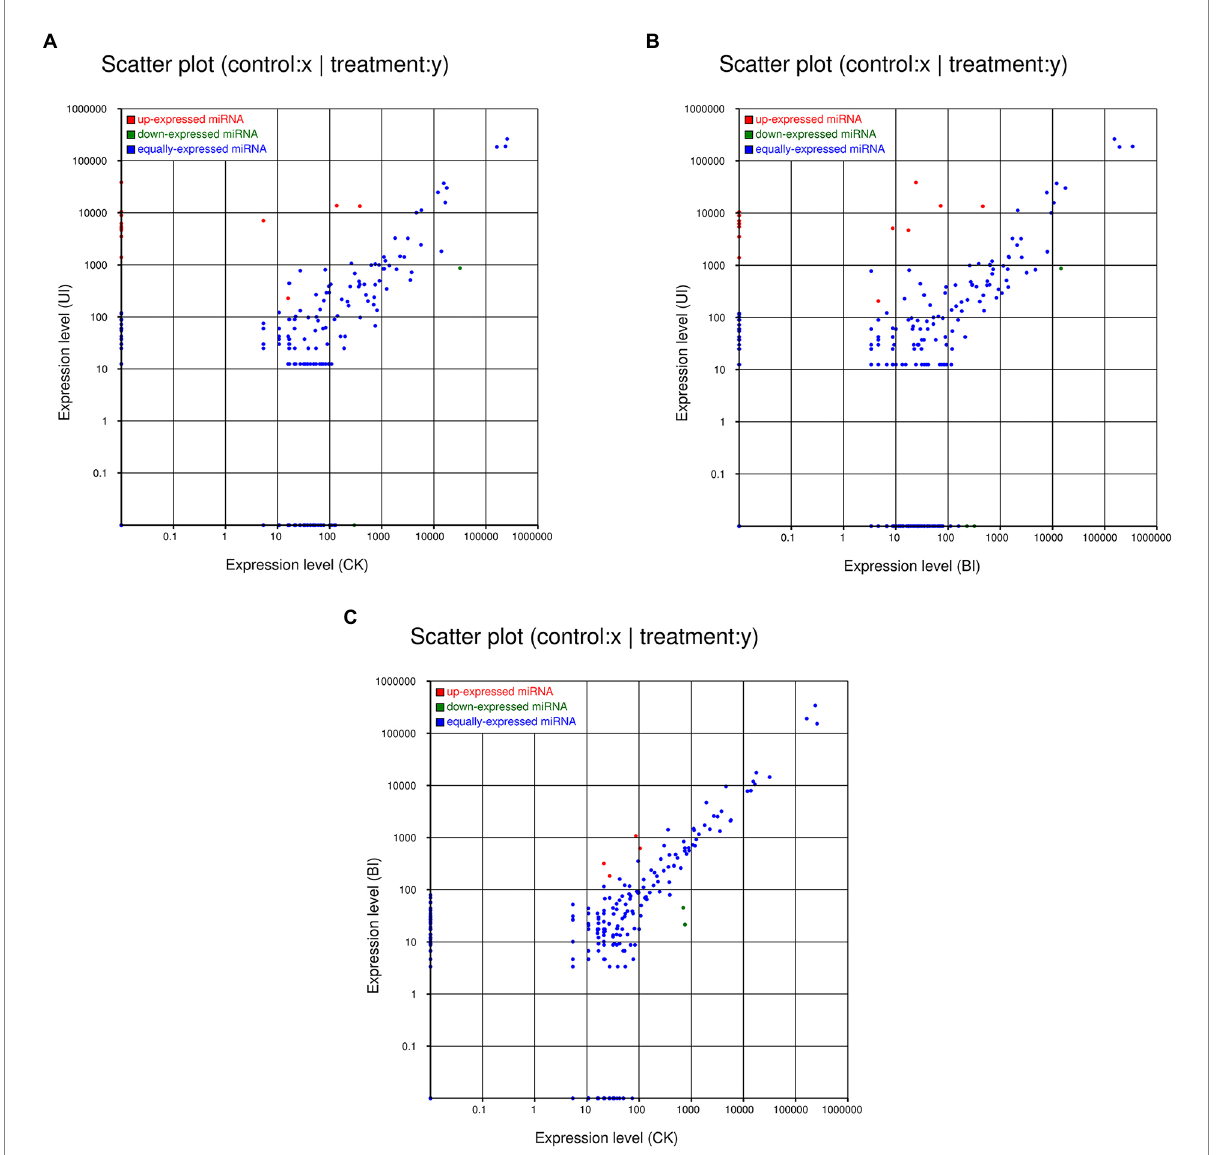
FIGURE 5 Comparisons of the different expression patterns of novel miRNAs between each pair of groups. Each point in the scatter plots represents one miRNA. The x -axis and y -axis individually show the expression levels between the two libraries. The red dots indicate a more abundant expression in the y -axis library (fold change > 1, p < 0.05); the blue dots indicate equal expression between the two libraries ( − 1 < fold change < 1, p > 0.05), and green dots indicate less enrichment in the y -axis library (fold change < − 1, p < 0.05). (A) Expression in the CK (control check, without inoculation) vs. expression in the UI (symbiotic phase, 5 weeks after inoculation), (B) expression in the BI (presymbiotic phase, 3 weeks after inoculation) vs. expression in the UI (symbiotic phase, 5 weeks after inoculation), and (C) expression in the CK (control check, without inoculation) vs. expression in the BI (presymbiotic phase, 3 weeks after